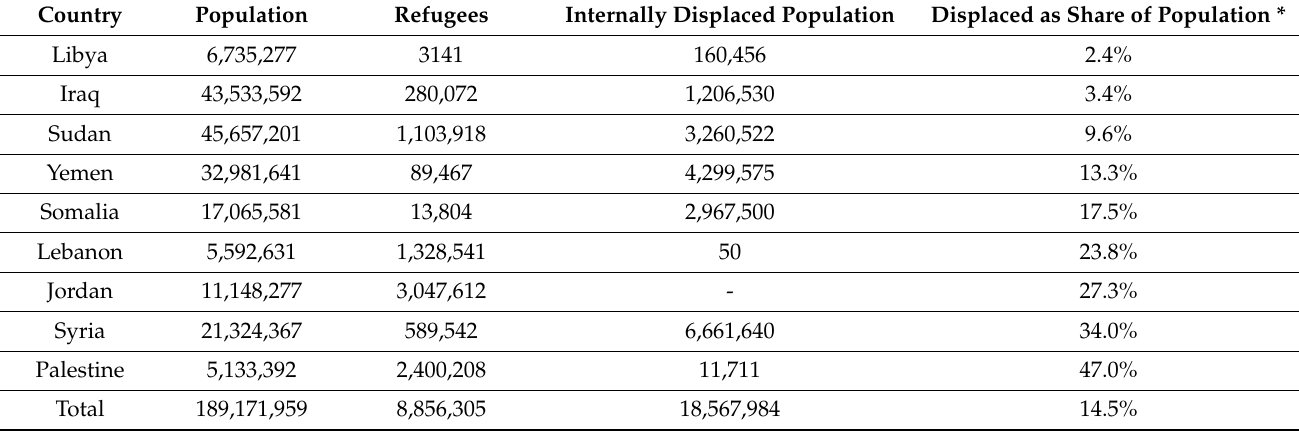
Table 3. Numbers and proportions of refugees and internally displaced populations in some countries of the